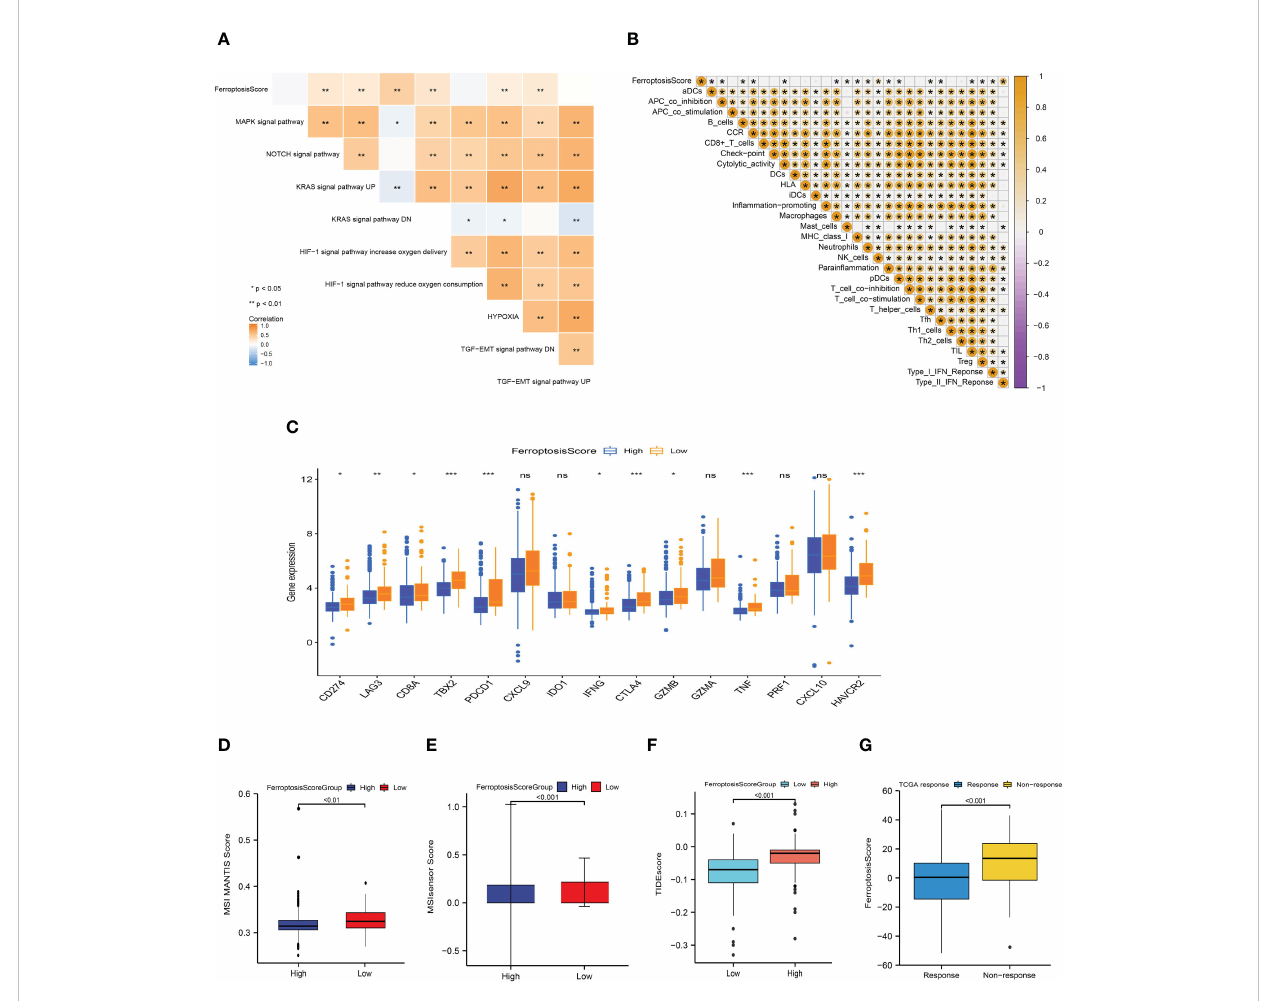
FIGURE 8 Ferroptosis score correlated with immunotherapy ef fi cacy and response to immunotherapy. (A, B) Heat maps of the correlation between ferroptosis score and carcinogenic related signaling pathways (A) and immune cell in fi ltration (B) . * p <0.05; ** p <0.01; *** p <0.001. (C) Box plot depicting the differences between the ferroptosis score groups in the relative expression of checkpoints. ns: not signi fi cant; * p <0.05; ** p <0.01; *** p <0.001. (D, E) Differences between ferroptosis score groups and MSI MANTIS score (D) and MSIsensor score (E) . (F) Box plot depicting the differences between the ferroptosis score groups in the TIDE score. (G) Box plot depicting the differences of ferroptosis score between the immunotherapy response